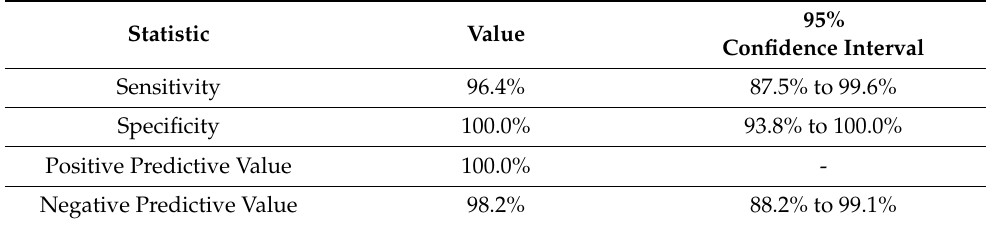
Table 2. Performance statistics of Rapid Screening Test for